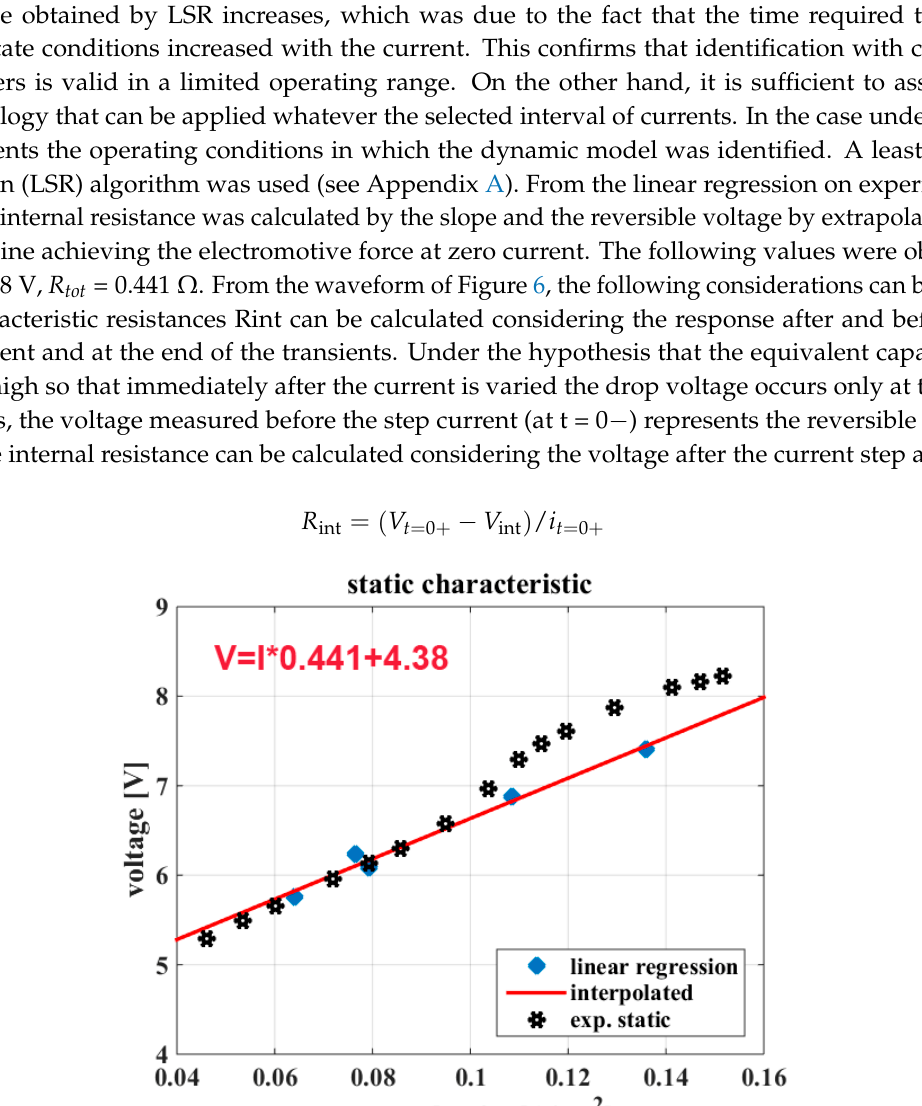
Figure 8. Input power vs. the current density supplied to the PEM EL. 4.3. Dynamic Model Identification In order to obtain the dynamic model, the transient has been considered considered. It is possible that there were two exponential transients corresponding to two different time constants. This is consistent with the considerations explained in Section 2. The time constants of the dynamic model have been obtained using an LSR algorithm as well (see Appendix A). In this case, since the curves are exponential, some manipulations have been performed in applying the LSR algorithm, as explained in the following. In the case under study, with a suitable choice of time origin, the voltage profile can be approximated as: